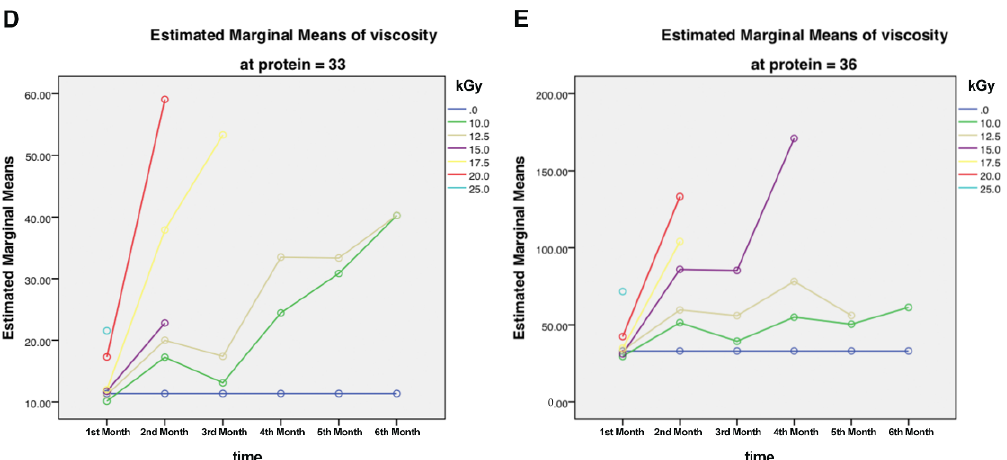
Figure 1. Effect of gamma radiation on viscosity of WPI solutions (10% protein). ( A ) The effects of gamma radiation (0–25 kGy) on viscosity of WPI solutions (27–36%) after gamma radiation. ( B – E ) Estimated marginal means of viscosity of WPI solutions, respectively, during six months. (*** p < 0.001).